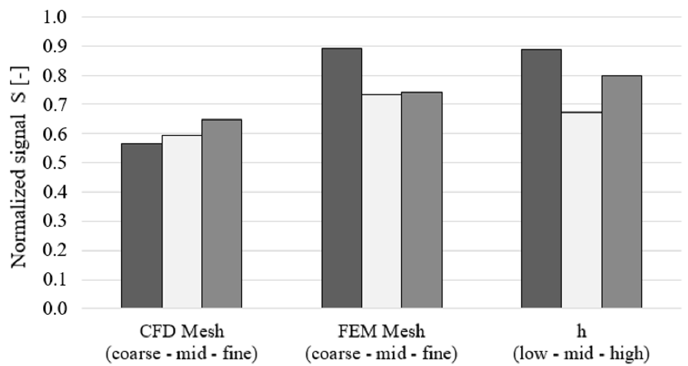
Figure 15. Normalized signal S dependence from factor levels in Orthogonal Array—integral of temperate deviation assigned to term A .